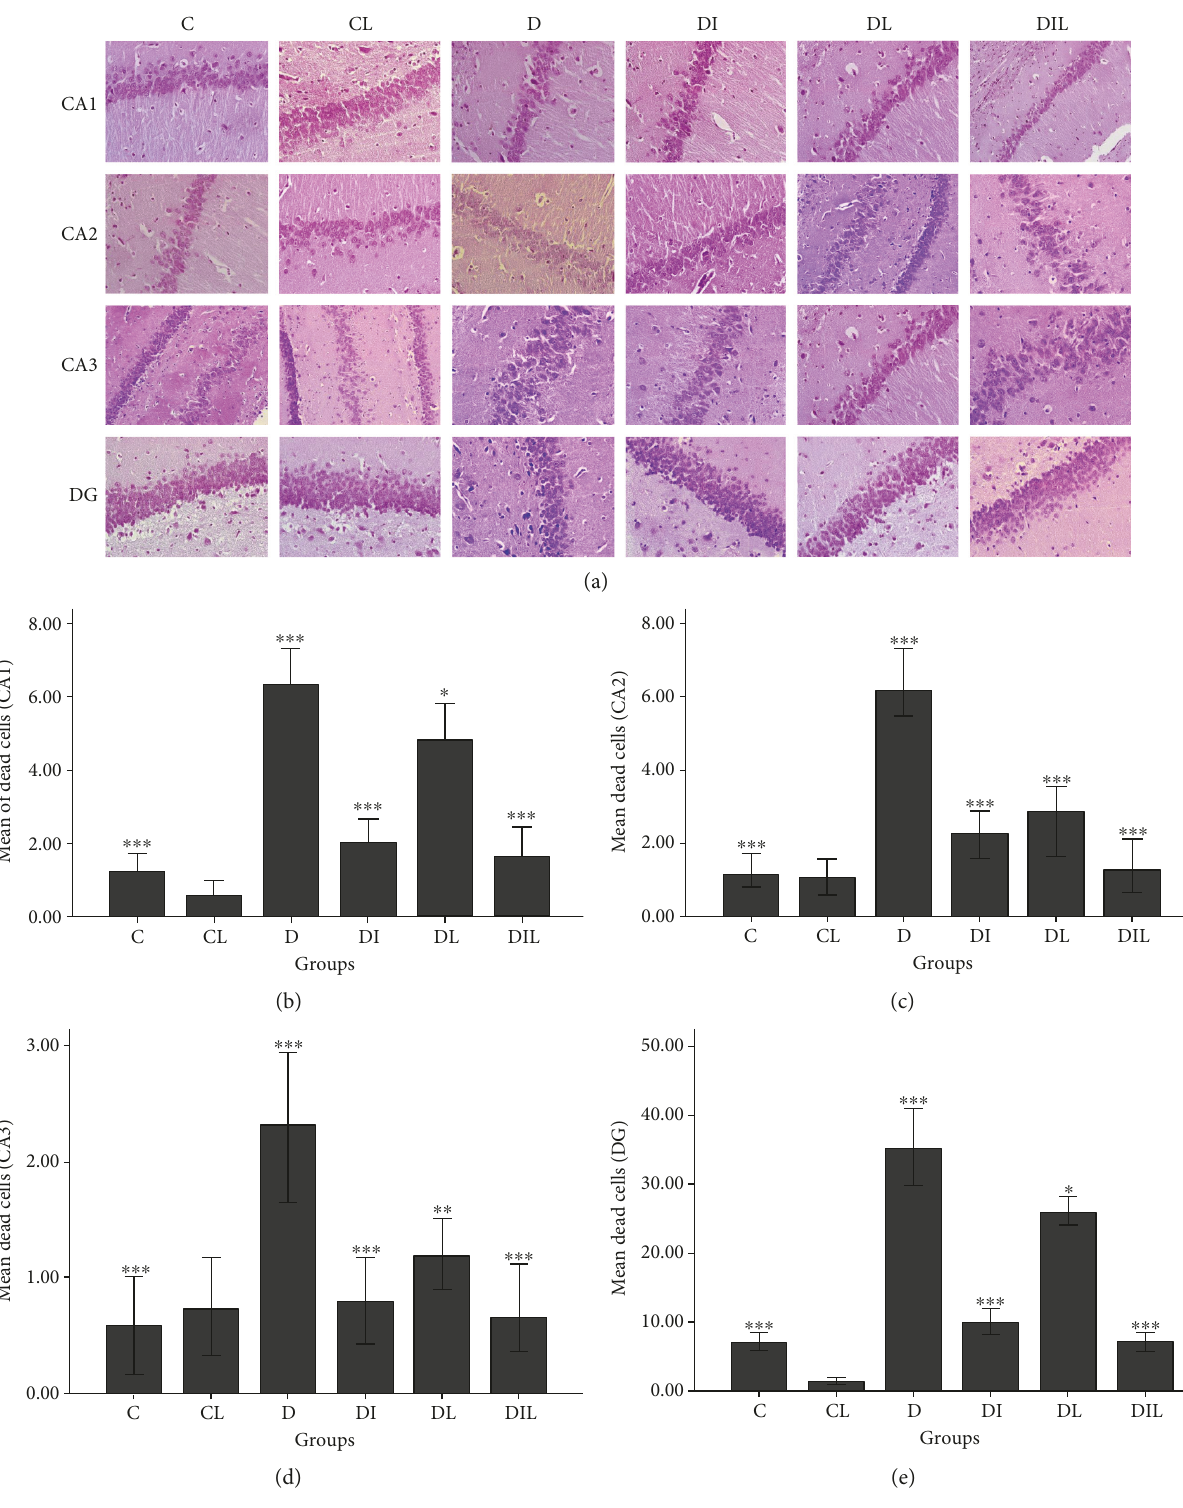
Figure 1: The e ff ects of insulin and lycopene on neural cell death of hippocampus. (a) Neuronal cell death was evaluated via hematoxylin- eosin staining at 40x magni fi cation. C: the control group; CL: the control group treated with lycopene; D: untreated diabetic group; DI: diabetic group treated with insulin; DL: diabetic group treated with honey; DIL: diabetic group treated with insulin and honey simultaneously. (b) ∗∗∗ p < 0 001 , comparing C, DI, and DIL with D. ∗ p < 0 05 , comparing D with DL. (c) ∗∗∗ p < 0 001 , comparing C, DI, DL, and DIL with D. (d) ∗∗∗ p < 0 001 , comparing C, DI, and DIL with D. ∗ p < 0 01 , comparing D with DL. (e) ∗∗∗ p < 0 001 , comparing C, DI, and DIL with D. ∗ p < 0 05 , comparing D with DL. Bar graphs indicate the mean ± SEM ( N = 8